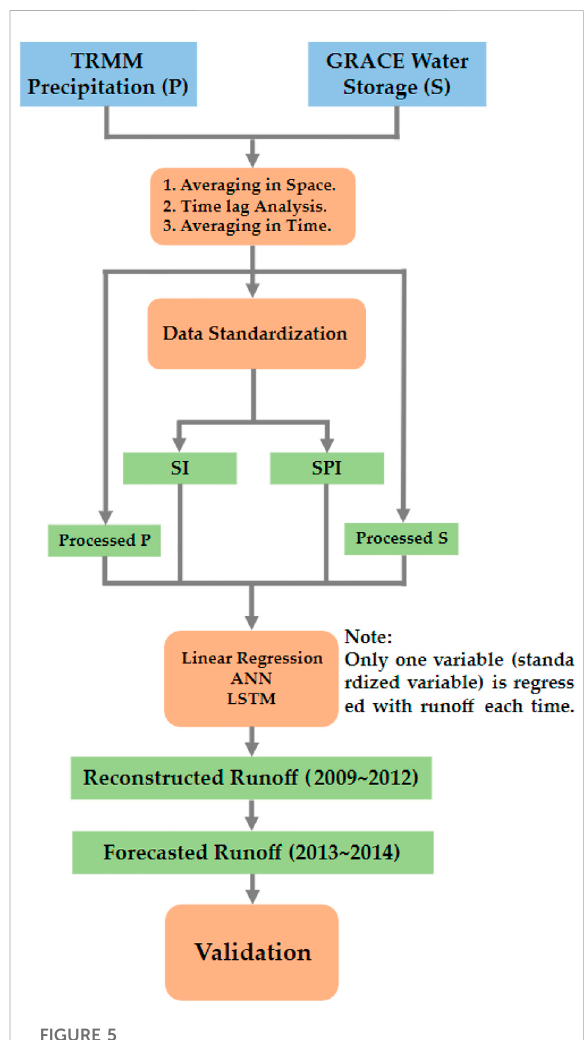
FIGURE 5 Flowchart describing the whole methodology of this